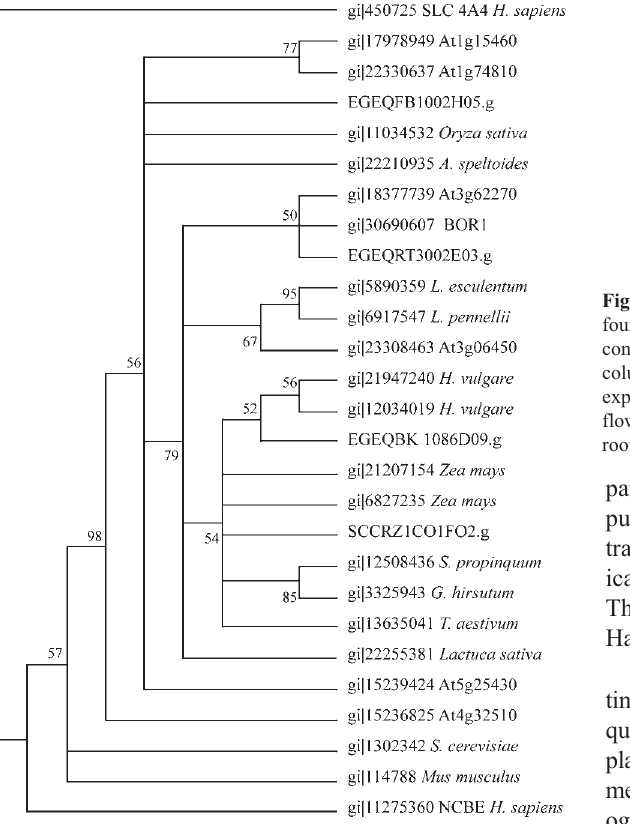
Figure 2 - Neighbor-joining tree showing the relationship between hypo- theticalconserveddomainsin BOR1 -likesequencesandputative Eucalyp- tus proteins. The tree was drawn using MEGA2, with bootstrap of 1000 replicates.Onlybootstrapvaluesof50%orhigherareshown.Eucalyptse- quences were represented as in FORESTs database (https://forests.esalq. usp.br) or SUCEST database (http://sucest.lad.ic.unicamp.br); other se- quences were represented by their access in GenBank (GI) and the rele- vant